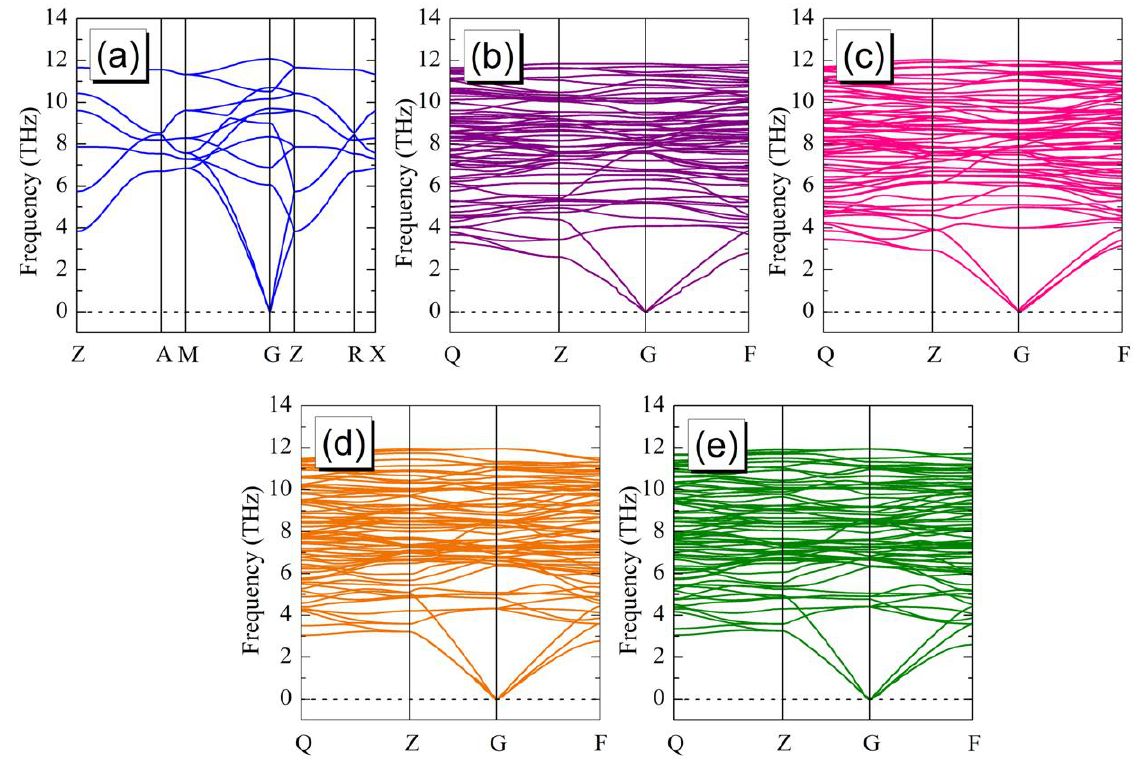
Figure 2. Calculated phonon dispersion curves for ( a ) perfect VSi 2 , ( b ) Si-va1, ( c ) Si-va2, ( d ) V-va1 and ( e ) V-va2, respectively. The capital letters on the horizontal axis indicate the high symmetry points in the first Brillouin zone.